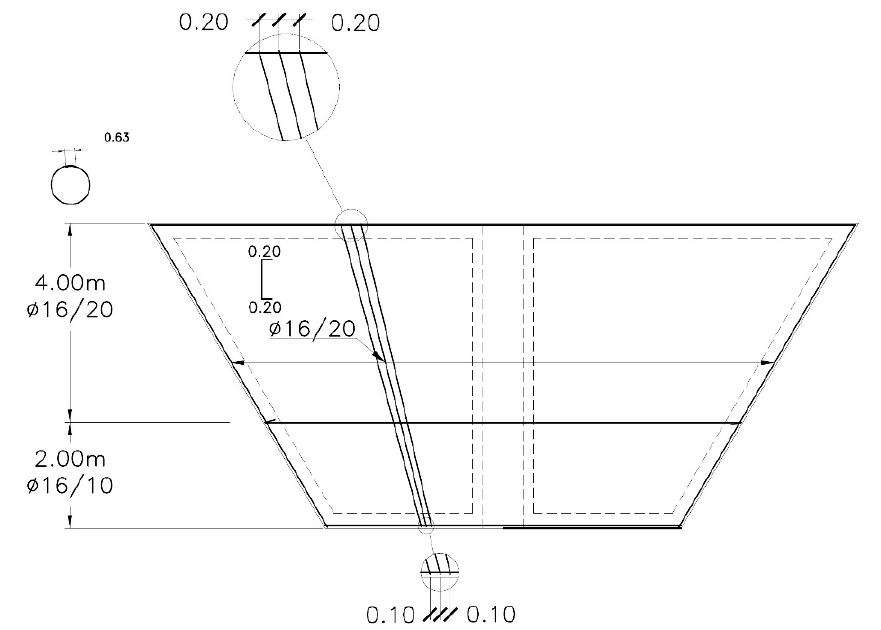
Figure 3. Steel reinforcement elevation of the reservoir.